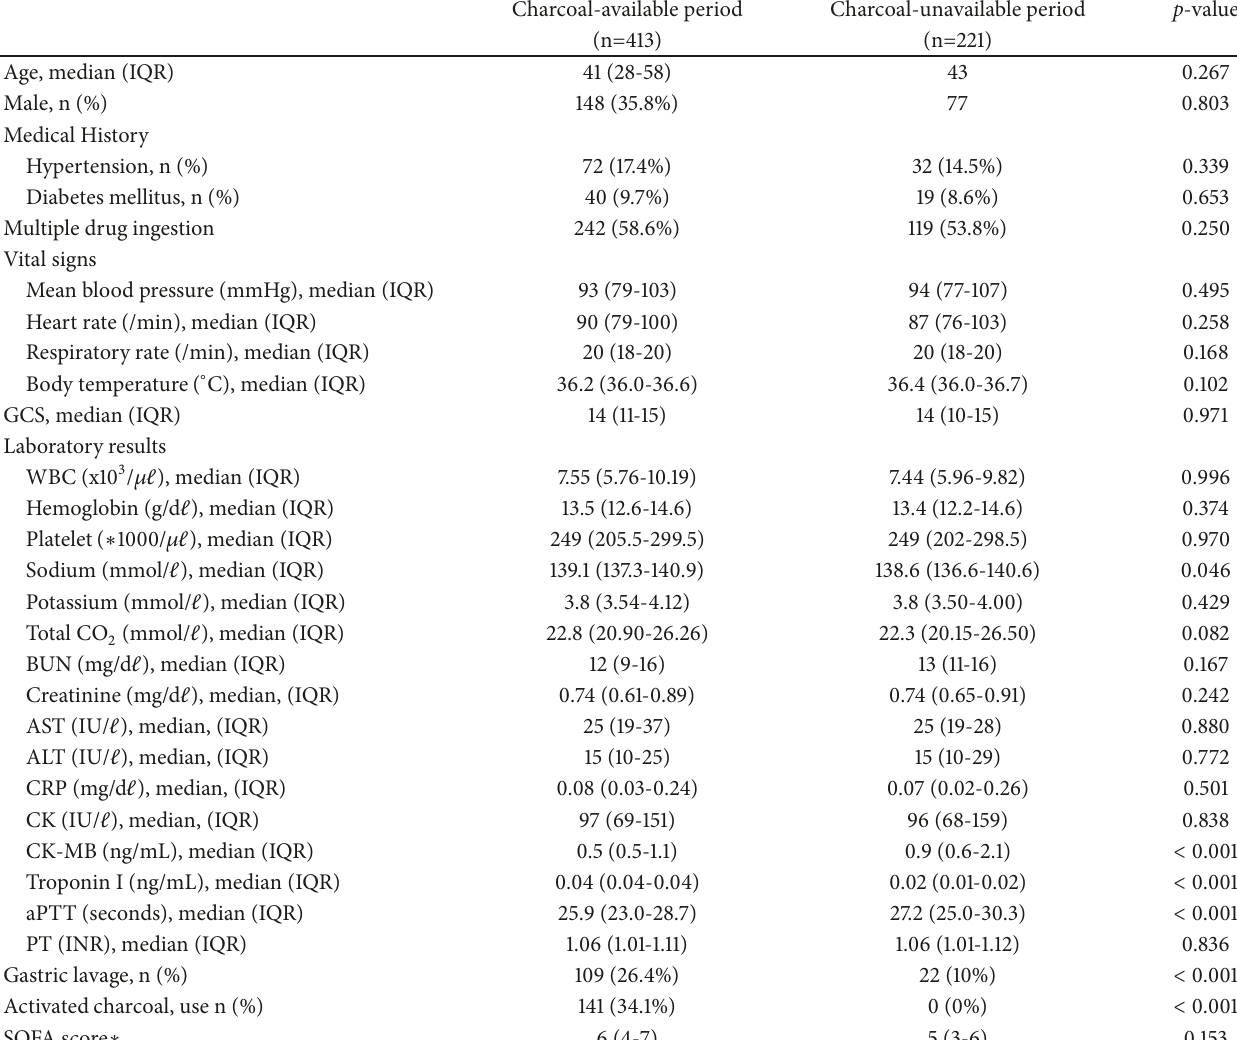
Table 1: Patient characteristics.